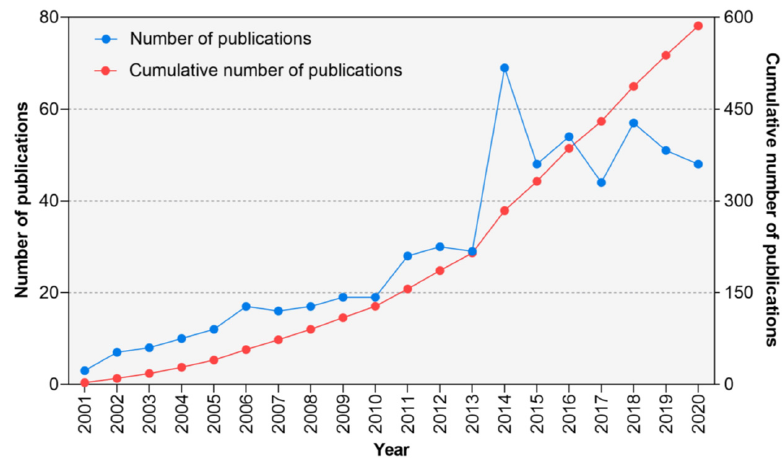
Figure 1. Number of publications and cumulative number of publications on rhythmic auditory stimulation publication. Alt text: A line graph plots the number of annual publications and cumulative number of publications among 2001–2020. A generally exponential growth is observed. A surge is observed in 2014. Table 1. The top 10 journals that published articles on rhythmic auditory stimulation research. Sources